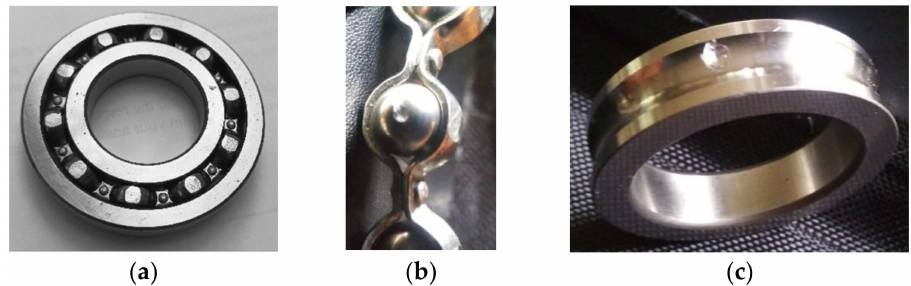
Figure 12. ( a ) Ball bearing used in the test, ( b ) ball fault, ( c ) inner race